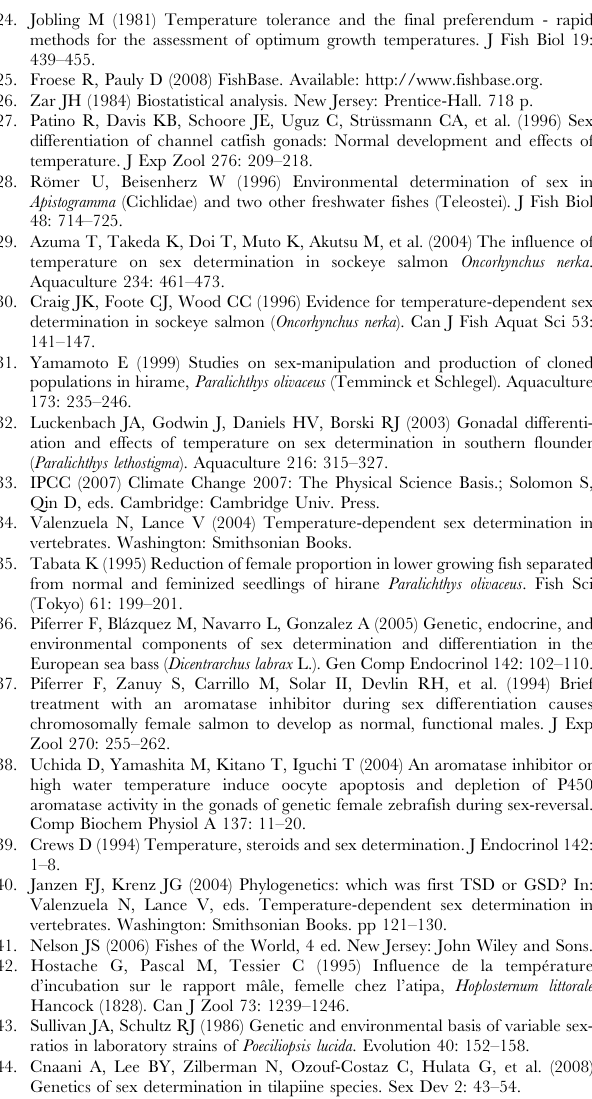
Table S1 Temperature-Dependent Sex Determination in Fish. Prevalence, Existence of a Single Sex Ratio Response Pattern, and Possible Effects of Climate